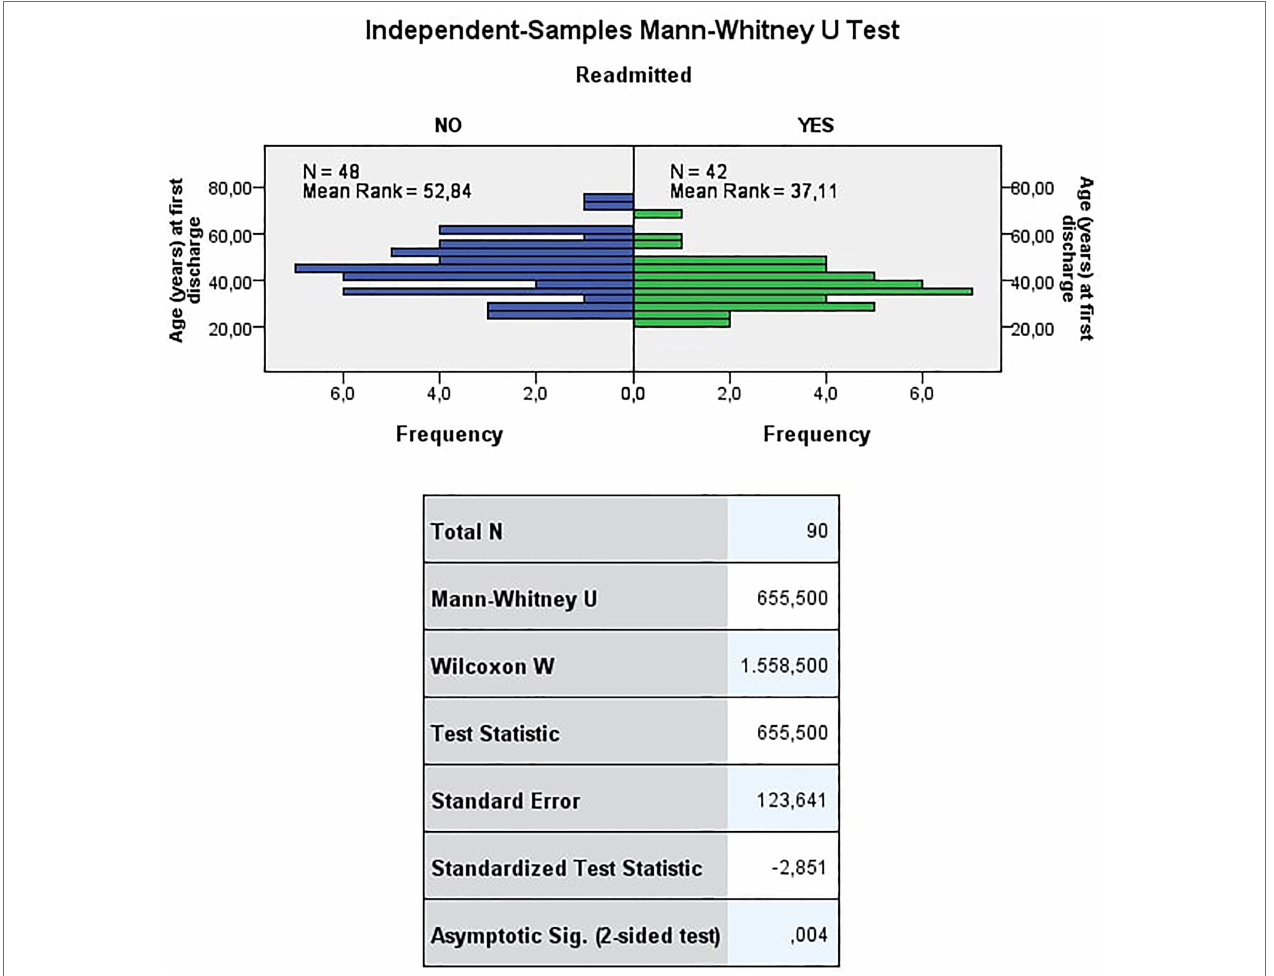
FIGURE 3 | Age (years) at first discharge. The test refuses the null hypothesis that the distribution of the age (years) at first discharge is the same across the categories of readmitted at a significance level of 0.01 (value of p < 0.01). Thus, being readmitted or not readmitted depends on the age at first discharge. Those who were not readmitted were, on average, significantly older than those who were readmitted.